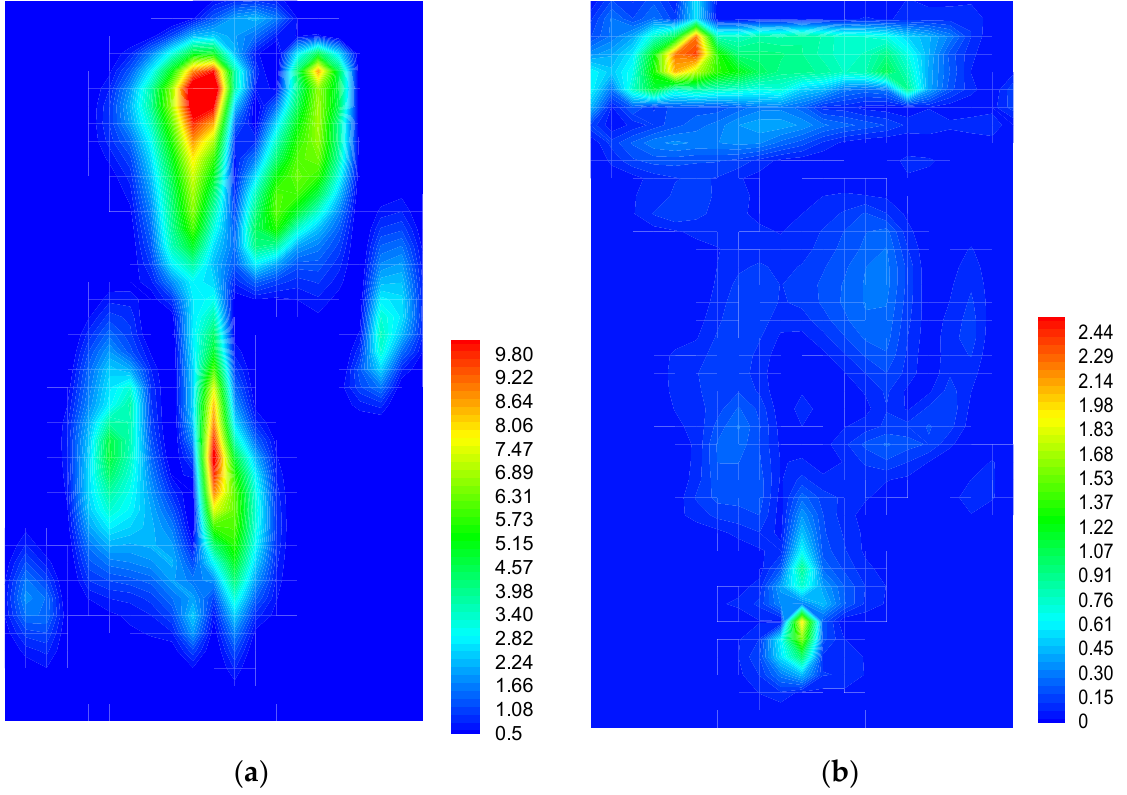
Figure 17. Distributions of granular temperature of particles with density of ρ p = 2700 kg/m 3 and ρ p = 800 kg/m 3 . ( a ) ρ p = 800 kg/m 3 ; ( b ) ρ p = 2700 kg/m 3 .